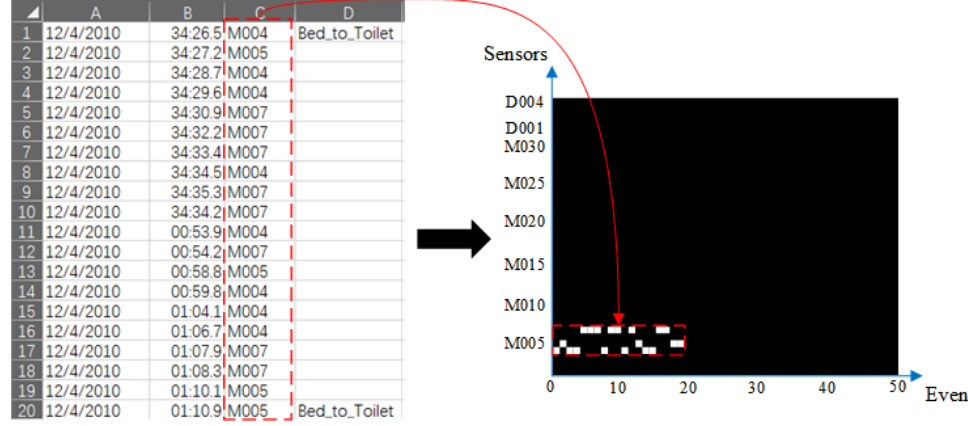
Figure 6. Activity (bed to toilet) sample with 20